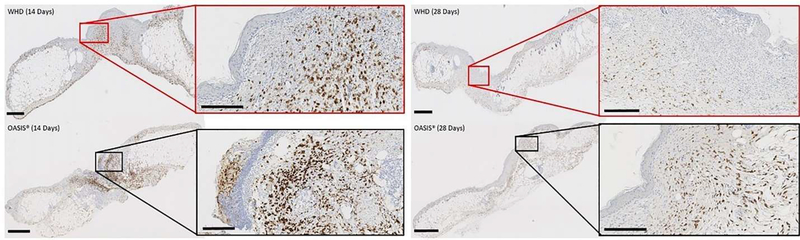
Phase I Immunohistochemistry (CD163) highlighting tissue macrophage presence in remodeled wounds at 14 days (left) and 28 days (right). The WHD demonstrated lower levels of tissue macrophage presence compared to Oasis.